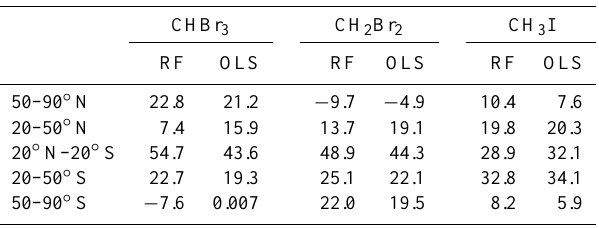
Table 3. The emission distribution of CHBr 3 , CH 2 Br 2 and CH 3 I calculated with two different regression methods (RF and OLS) for different latitudinal bands (see text for explanation), expressed as a